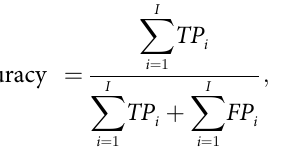
Table 2. Performances of the baseline and our proposed method on UCF101 (split1), HMDB51 (split1), and JHMDB (split1). Model UCF101 (split1) ResNet152 SA-ResNet152 SA-ResNet152+TSN